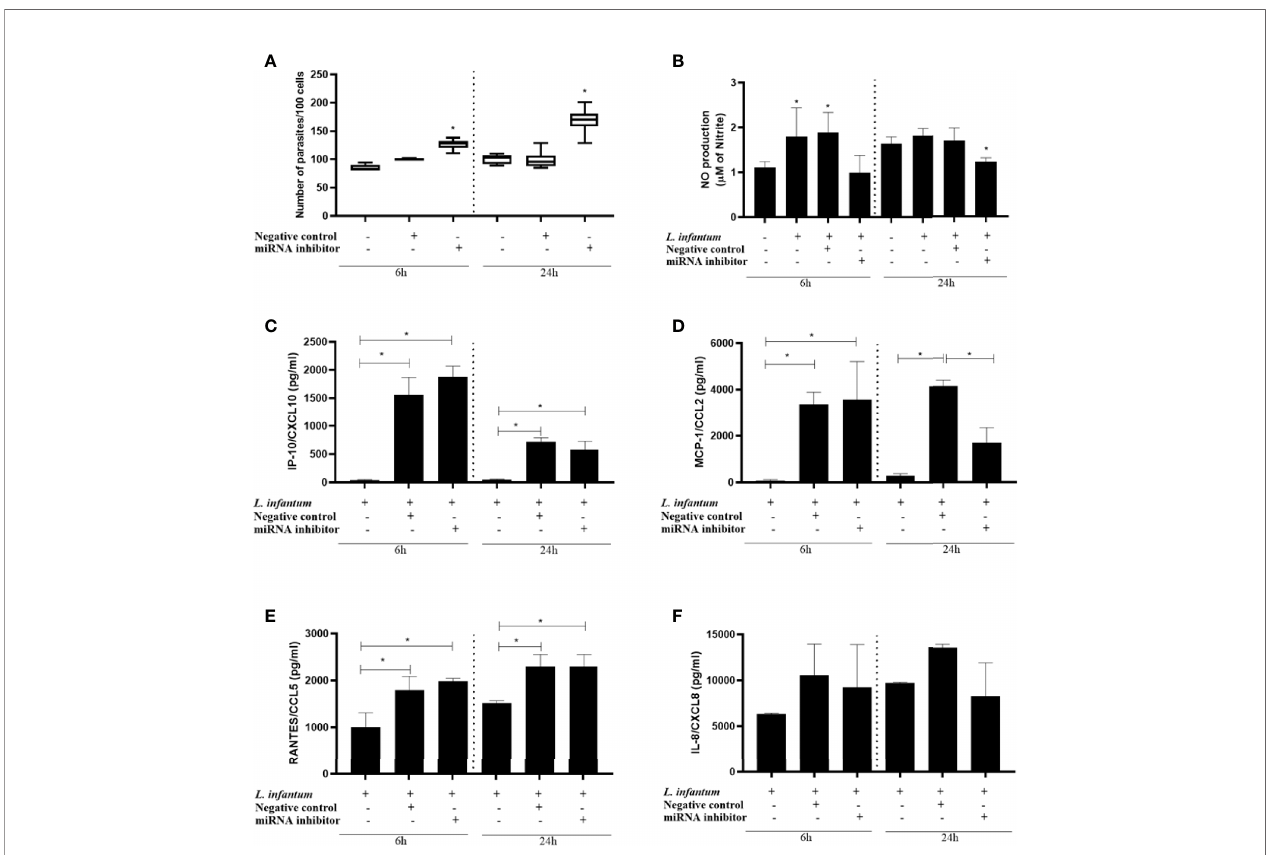
FIGURE 5 | Parasite load, nitric oxide production, and chemokine levels in L. (L.) infantum promastigote-infected THP-1 cells transiently transfected with miR-548d-3p inhibitor. THP-1 cells were transiently transfected with miR-548d-3p inhibitor (10 nM) or negative control (scrambled miRNA; 10 nM) as described in Methods. After 24h, macrophages were infected with L. (L.) infantum promastigotes and incubated for 6 and 24h post-infection for different evaluations. (A) Parasite load represented as the number of parasites/100 cells. (B) Nitric oxide (NO) production was determined by the accumulation of nitrite in the cell culture supernatants. IP-10/CXCL10 (C) , MCP1/ CCL2 (D) , RANTES/CXCL5 (E) , and IL-8/CXCL8 (F) concentrations (pg/mL) were measured by fl ow cytometry using the CBA kit. * = P < 0.05 (one way ANOVA and Tukey´s test). One representative experiment from three independent assays is